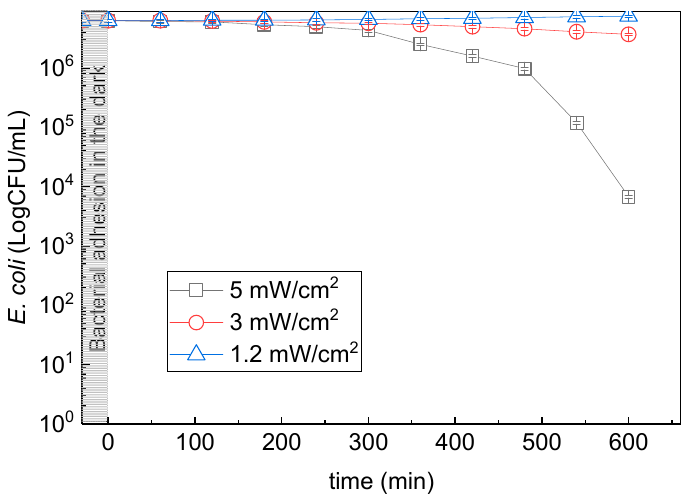
Figure 7. E. coli inactivation under different intensities of indoor light (see conditions in Section 2.4.4).